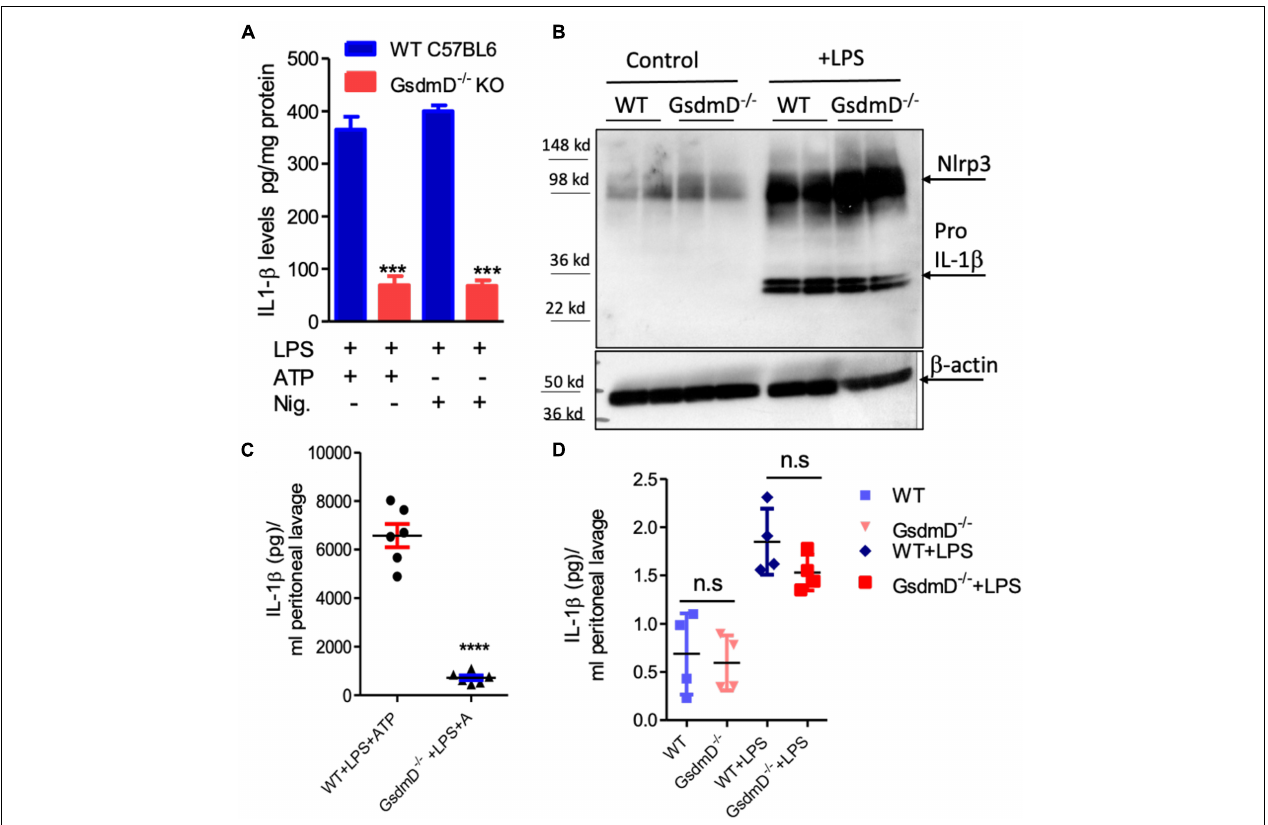
FIGURE 1 | (A) Gasdermin D (GsdmD) plays a role in release of mature IL-1 β upon in vivo Nlrp3 inflammasome activation. (A) BMDMs isolated from WTC57BL/6J or C57BL6/J-GsdmD - / - mice were primed by incubation with ± 1 µ g/ml LPS for 4 h. The Nlrp3 inflammasome assembly was induced either by incubation with 1 mM ATP for 20 min or 1 µ M Nigericin for 1 h. The IL-1 β levels in the cell-free media were measured by ELISA (mean ± SD, N = 6, *** represent p < 0.001 by ANOVA with Bonferroni post-test). (B) WT or GsdmD - / - BMDMs were treated ± 1 µ g/ml LPS, followed by western blot analysis using Nlrp3 and-IL-1 β antibodies. The β -actin was used as a loading control. (C) The age-matched male WTC57BL/6J or GsdmD - / - mice were primed with IP injection of LPS (5 µ g/mouse). After 4 h of LPS injection, the Nlrp3 inflammasome assembly in mice was induced by IP injection of ATP (0.5 ml of 30 mM, pH 7.0). The peritoneal cavity was lavaged with 3 ml PBS, and IL-1 β levels in peritoneal lavage were determined by ELISA ( N = 6, **** p < 0.0001 by two-tailed t -test). (D) The age-matched male WTC57BL/6J or GsdmD - / - mice were treated with ± IP injection of LPS (5 µ g/mouse) and injected with 0.5 ml of saline. The peritoneal cavity was lavaged with 5 ml PBS, and IL-1 β levels